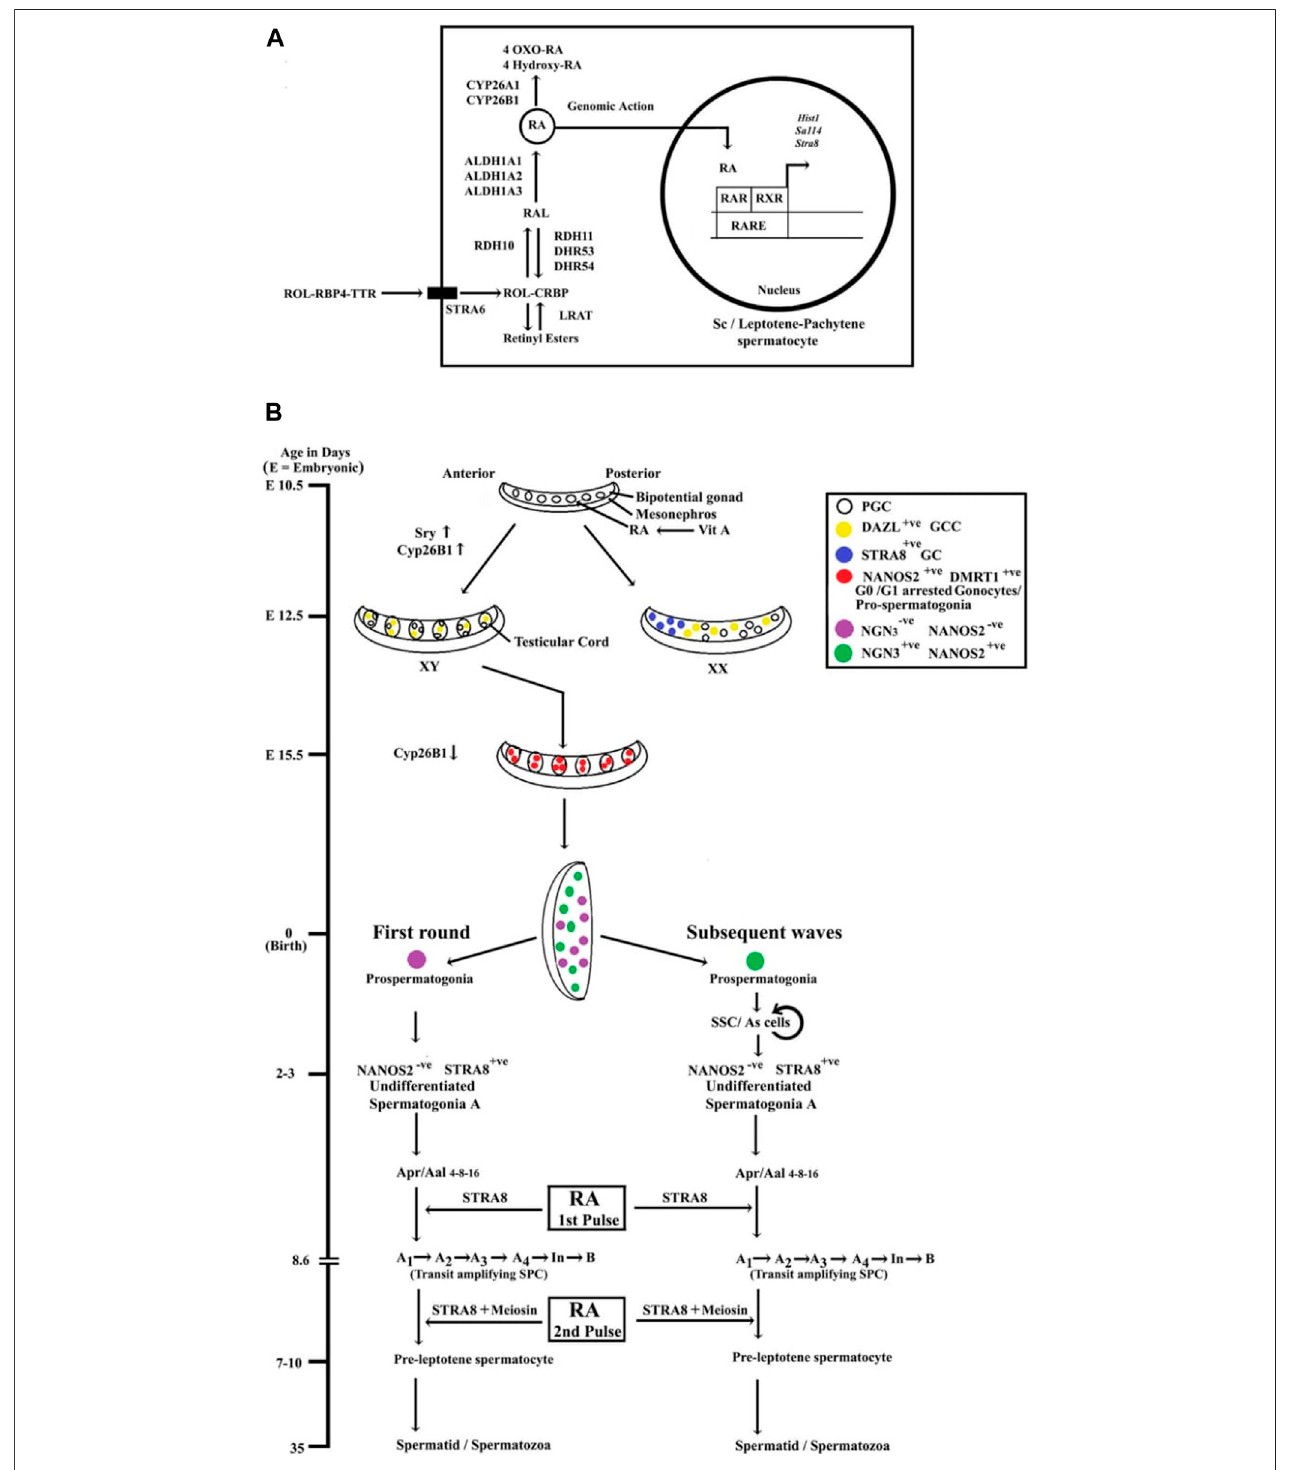
FIGURE1|(A) ThebiosynthesisandsignalingofRAintesticularScand/ormeioticGc.VitaminAorretinol(ROL)issynthesizedintheliveranddeliveredtotestes via retinol-binding protein 4 (RBP4) and transthyretin (TTR). ROL is uptaken by a membrane-bound receptor termed stimulated by retinoic acid gene 6 (STRA6) expressed by Sc. In Sc, lecithin retinol acyltransferase (LRAT) can convert ROL [bound with cellular retinol-binding protein (CRBP)] into retinyl esters, or ROL gets converted into retinal (RAL) by NAD + -dependent retinol dehydrogenase 10 (RDH10). The reverse step, i.e., conversion of RAL to ROL, is also mediated by NADPH-dependent retinal reductases (RDH11, DHRS3, and DHRS4). In both Sc and meiotic Gc, the second step, i.e., the irreversible oxidation of RAL to RA, is catalyzed by the